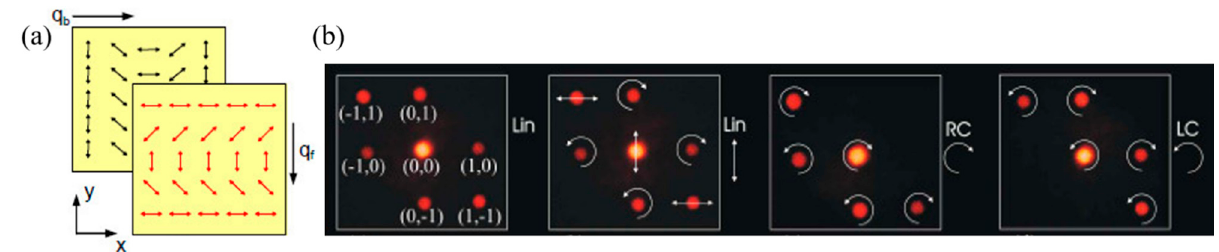
Figure 1. ( a ) Structure of the 2D LC PG by cross-assembling two 1D polarization patterns. ( b ) Diffraction patterns with different incident polarizations. Reproduced with permission from Reference [30] © The Optical Society.